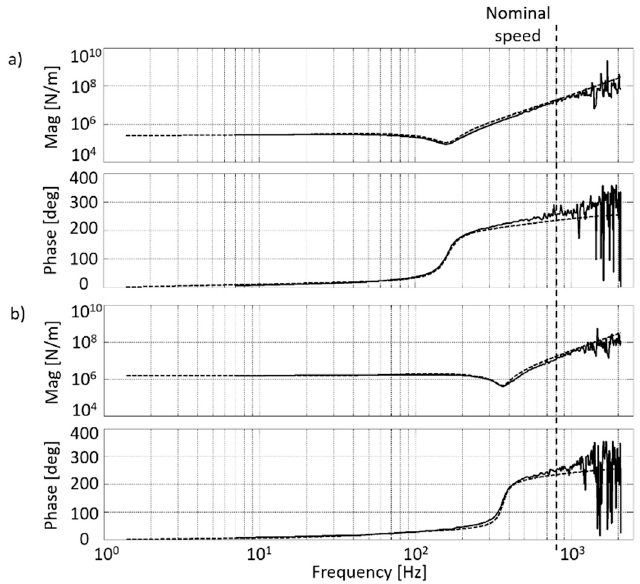
Figure 7. Numerical H NUM (dashed line) and experimental H EXP (solid line) behavior of the damper. ( a ) SES support of the turbo-molecular pump. ( b ) CS support of the turbo-molecular pump.